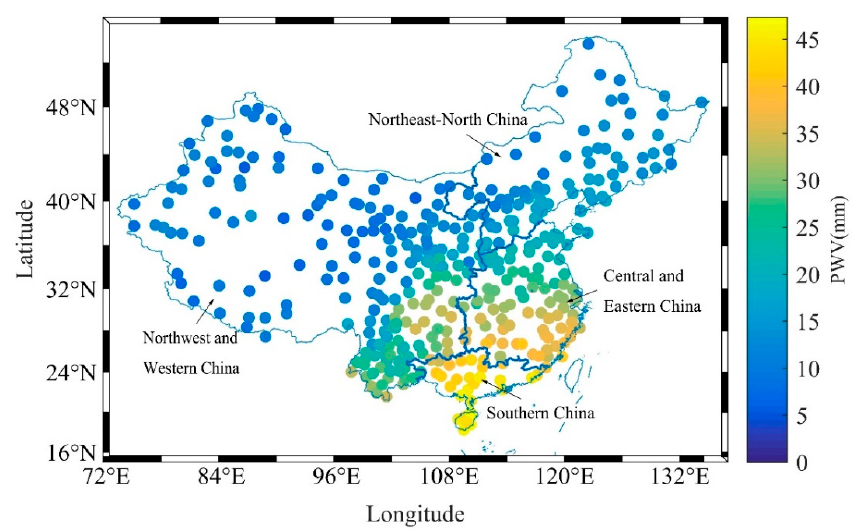
Figure 8. Annual averaged PWV (mm) in China from 2011 to 2019.